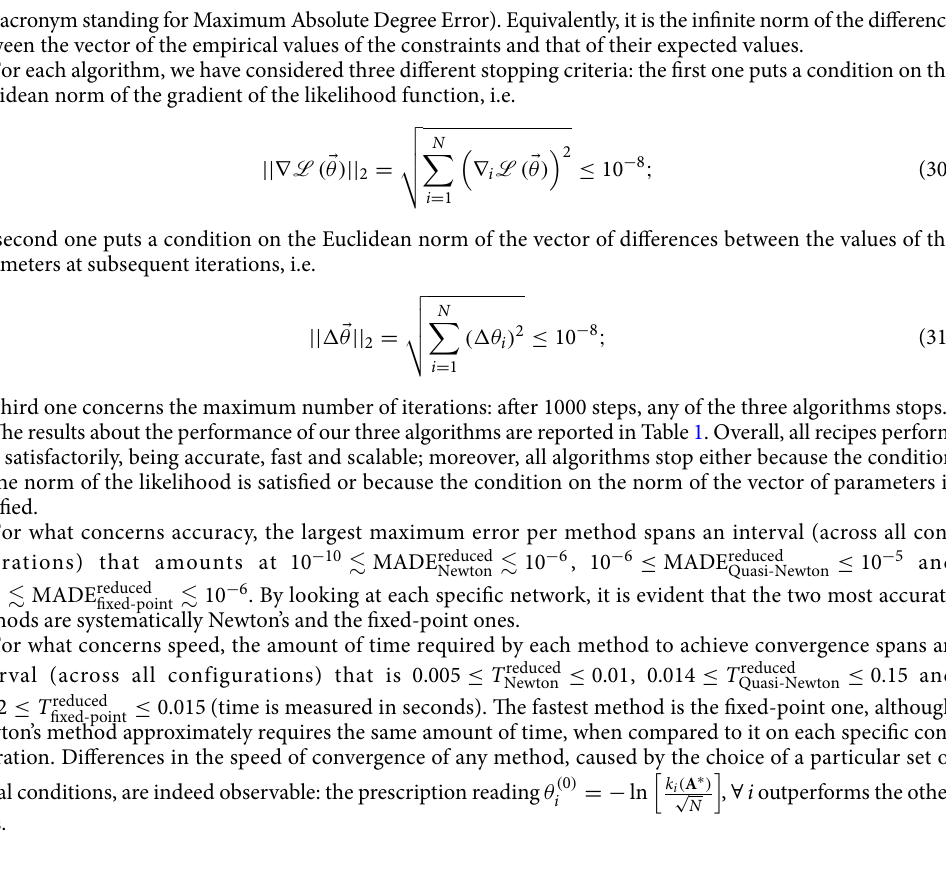
the empirical value of the i -th constraint, C i ). Naturally, in the UBCM case, C i error score becomes